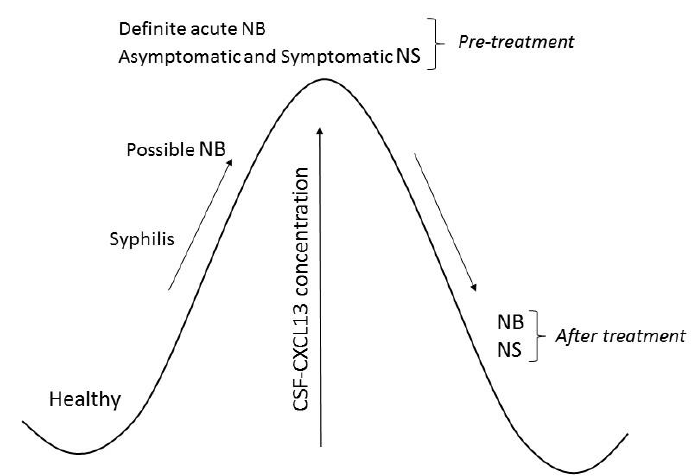
Figure 1. Chemokine ligand 13 (CXCL13) concentration in cerebrospinal fluid (CSF) of patients with neuroborreliosis (NB) and neurosyphilis (NS). Table 1. Significance of Chemokine ligand 13 (CXCL13) as a candidate diagnostic marker for neuroborreliosis (NB) and neurosyphilis (NS). Results